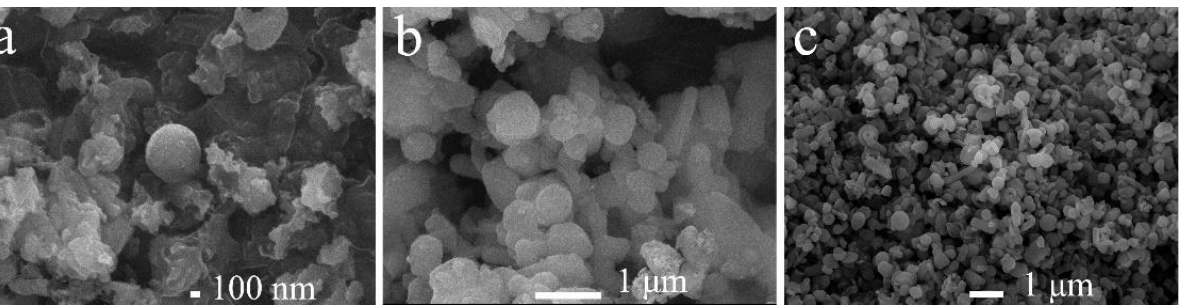
Figure 9. SEM images of the samples. ( a ) Mesoporous material synthesized with Gemini ionic liquid surfactant [N 1116 C 3 IMC 16 ][Br] 2 as template; ( b ) Mesoporous material synthesized with Gemini ionic liquid surfactant [N 1116 C 3 N 1116 ][Br] 2 as template; ( c ) Mesoporous material synthesized with Gemini ionic liquid surfactant [C 16 IMC 3 C 16 IM][Br] 2 as template. Transmission electron microscopy (TEM) images of the three samples are shown in Figure 10. Figure 10 shows that the three samples have clear (100) and (110) crystal planes of hexagonal phase, which proves that the samples have good two-dimensional hexagonal ordered pores. The sample pore size is about 3~4 nm. This result is consistent with the BJH test result. At the same time, the formation of mesoporous molecular sieves with the above structure shows that ionic liquids as templates form hexagonal micelles in